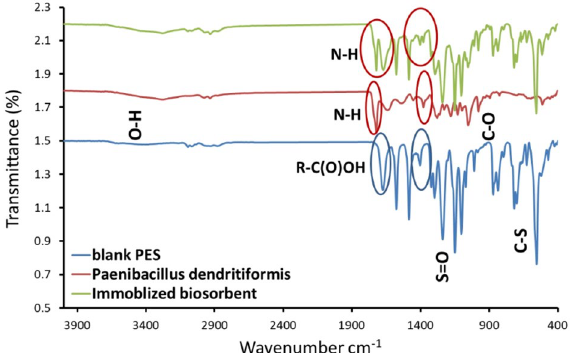
Figure 8. FT-IR spectrum of neat PES, Paenibacillus dendritiformis 17OS, and immobilized biosorbents.